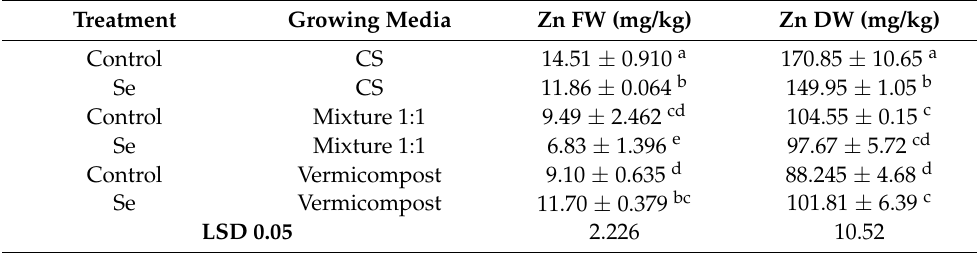
Table 5. Mean values ± standard deviations of the Zn concentration in the fresh-weight (FW) and dry- weight (DW) lamb’s lettuce tissue. The different letters represent the significance of the differences at the α = 0.05 level.